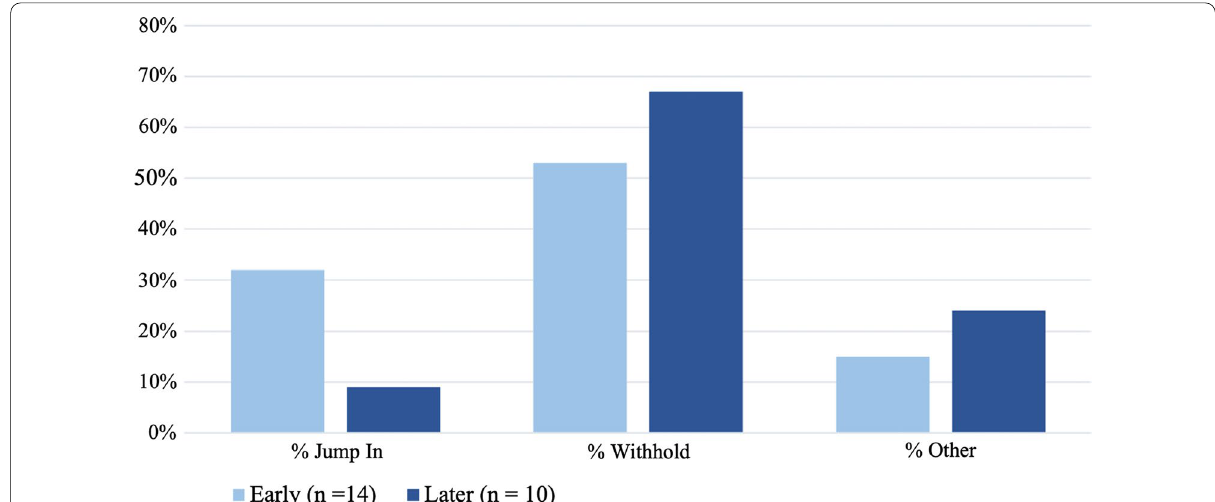
Fig. 8 Results of segment sequence analysis. The percentage of segments in which Craig responded by jumping in , withholding , or providing another ( other ) type of response in early versus later meetings ( n is the average number of segments in meetings during the five early and five later